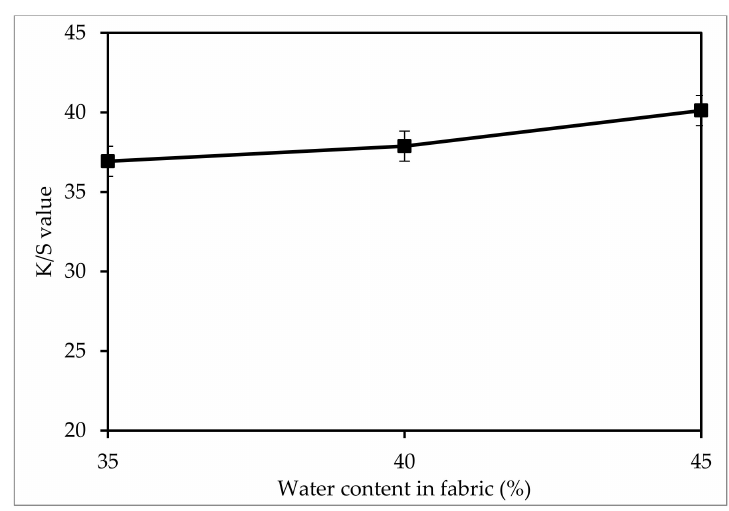
Figure 3. Effect of water content in fabric in plasma-induced ozone colour-fading effect on the sulphur-dyed knitted cotton fabric.